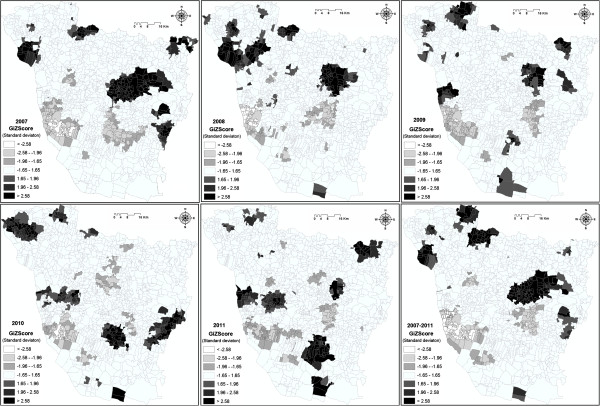
Maps showing the hotspot and cold spot over different years (2007–2011) in Vaishali district.